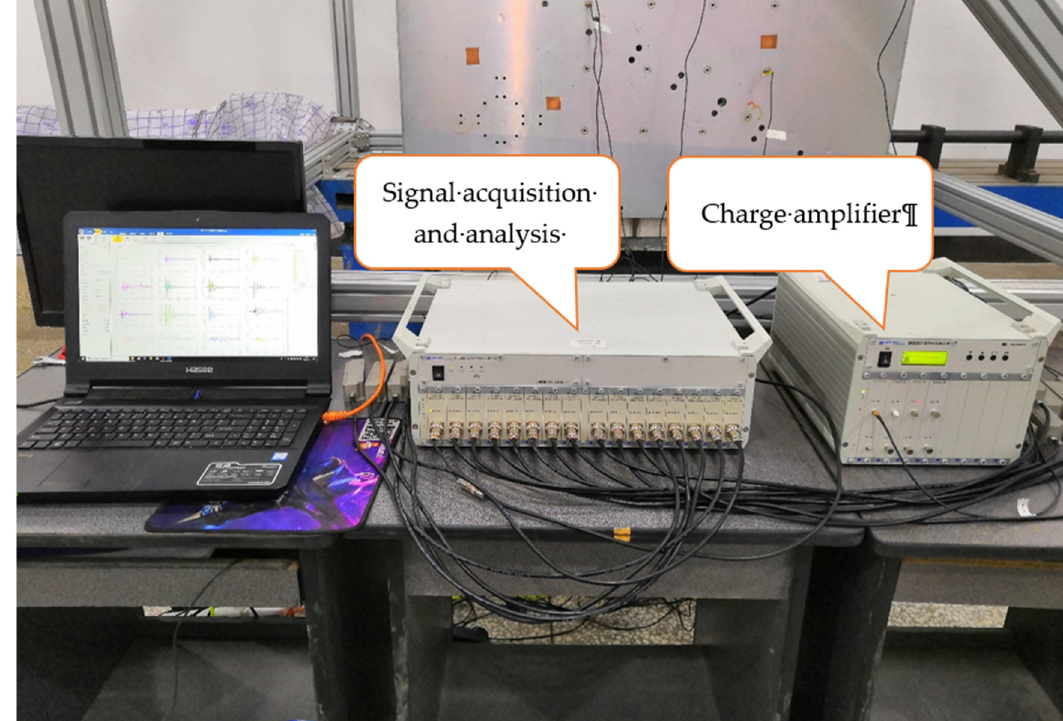
Figure 5. The measurement and control system of the experiment.